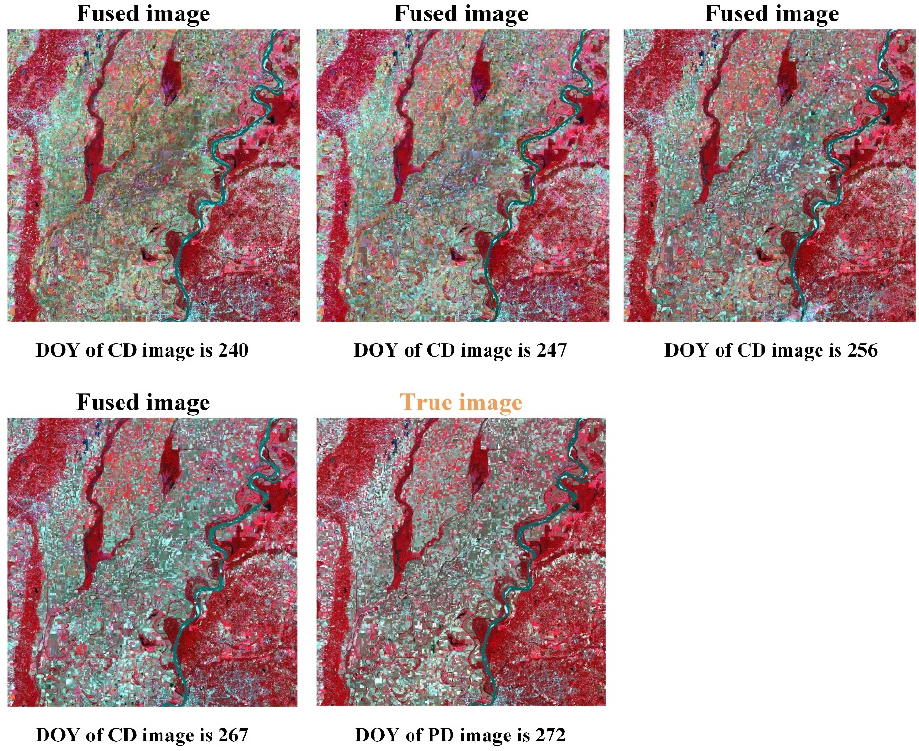
Figure 10. Standard false-color-composited images of the fused images with different CDs for the MNLC period and the true image.